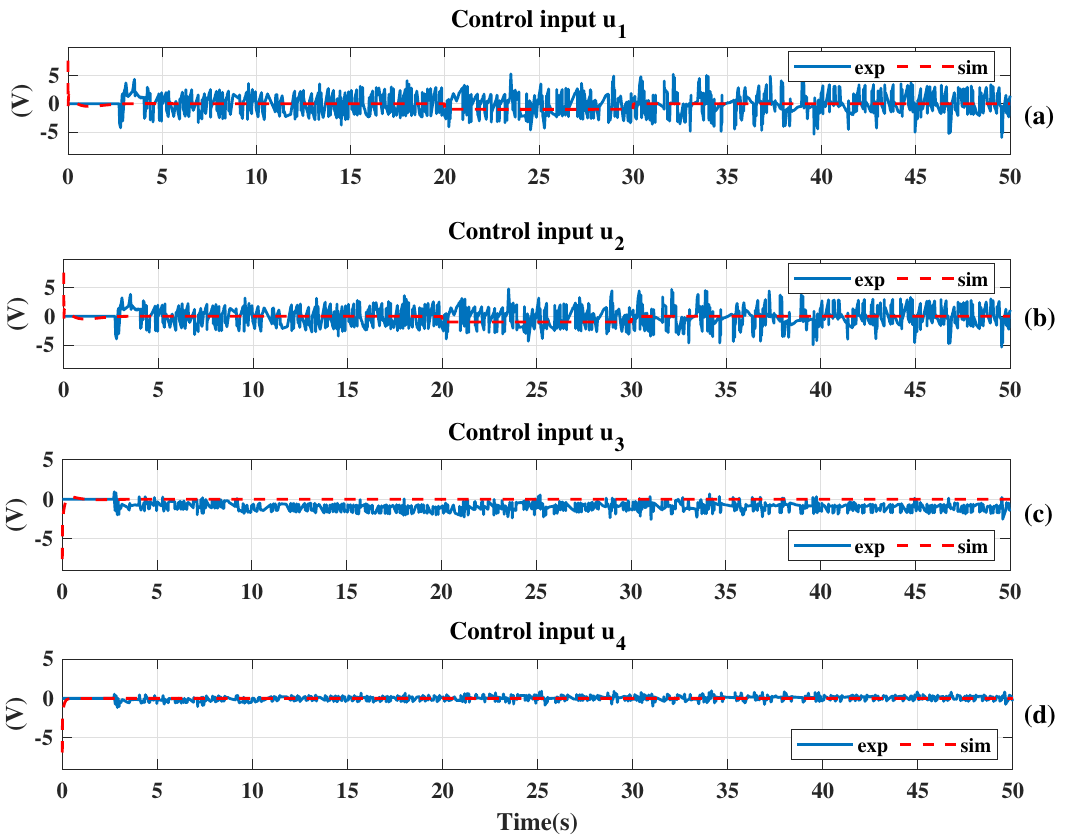
Figure 10. Control inputs: ( a ) Control input u 1 for the right wheel motor, ( b ) control input u 2 for the left wheel motor, ( c ) control input u 3 for the second link motor and, ( d ) control input u 4 for the third link motor.